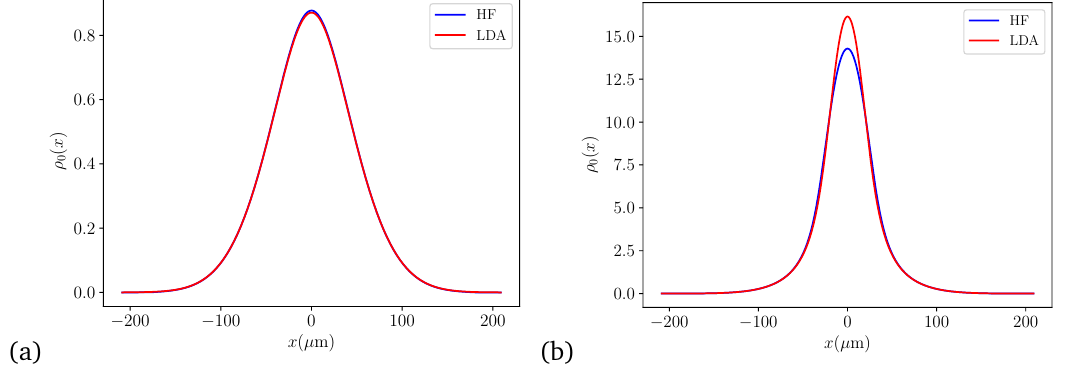
Figure 3: Comparison between density profiles of a single gas in a harmonic longi- = 2 π · 12.5Hz, computed in Yang–Yang thermodynamics tudinal potential with ω x with LDA (red), versus HF (blue), at T = 60nK. For a low particle number (panel (a), N = 99), the correspondence is good, whereas for N = 986 (b), the central density peak is underestimated in